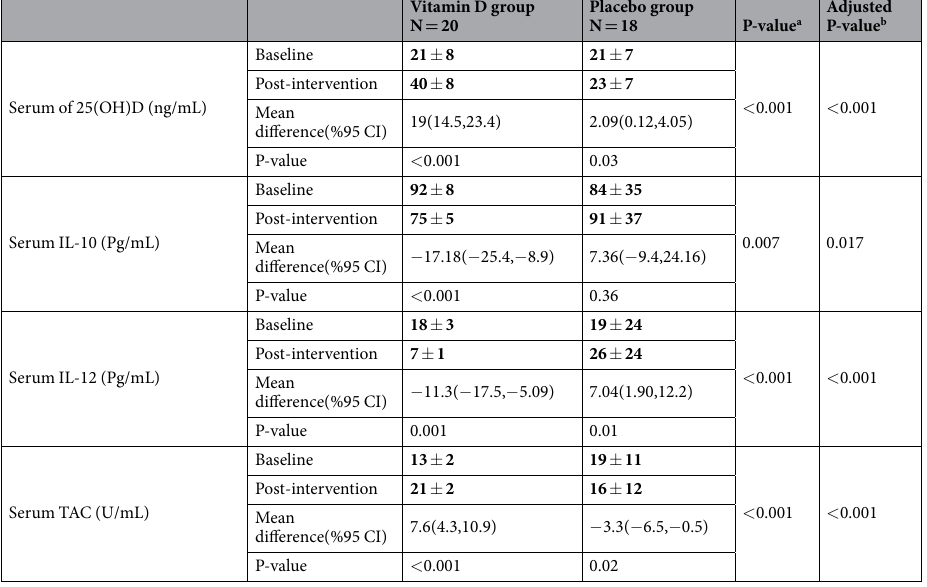
Table 3. Within- and between-group comparison of changes in serum levels of 25(OH)D, inflammatory and antioxidant markers in the two groups of study. a Resulted from independent samples t-test based on comparing mean difference between two groups. b Resulted from ANOCOVA based on comparing post-intervention values after adjustment for baseline values of outcomes, energy and vitamin E intake. Data are shown as mean ± SD. * Significant differences between groups (p < 0.05).